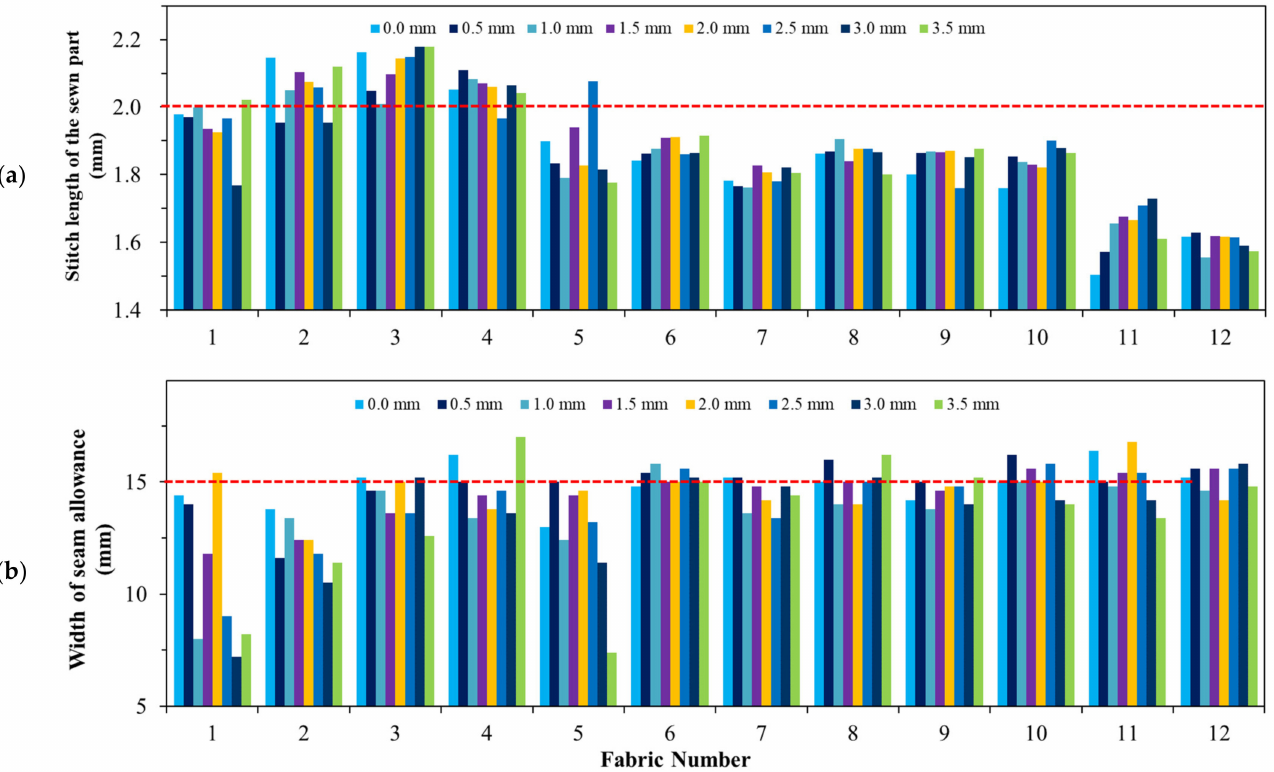
Figure 5. Sewability of the lock stitch according to the change in the presser height: ( a ) stitch length, ( b ) width of the seam allowance.